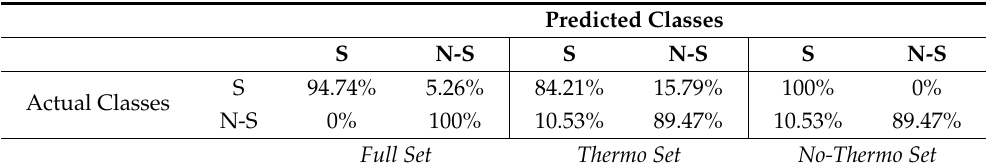
Table 2. Confusion matrices. N-S: non-stress; S: stress. The percentage of true positives and true negatives of each class is represented in the diagonal of each table.